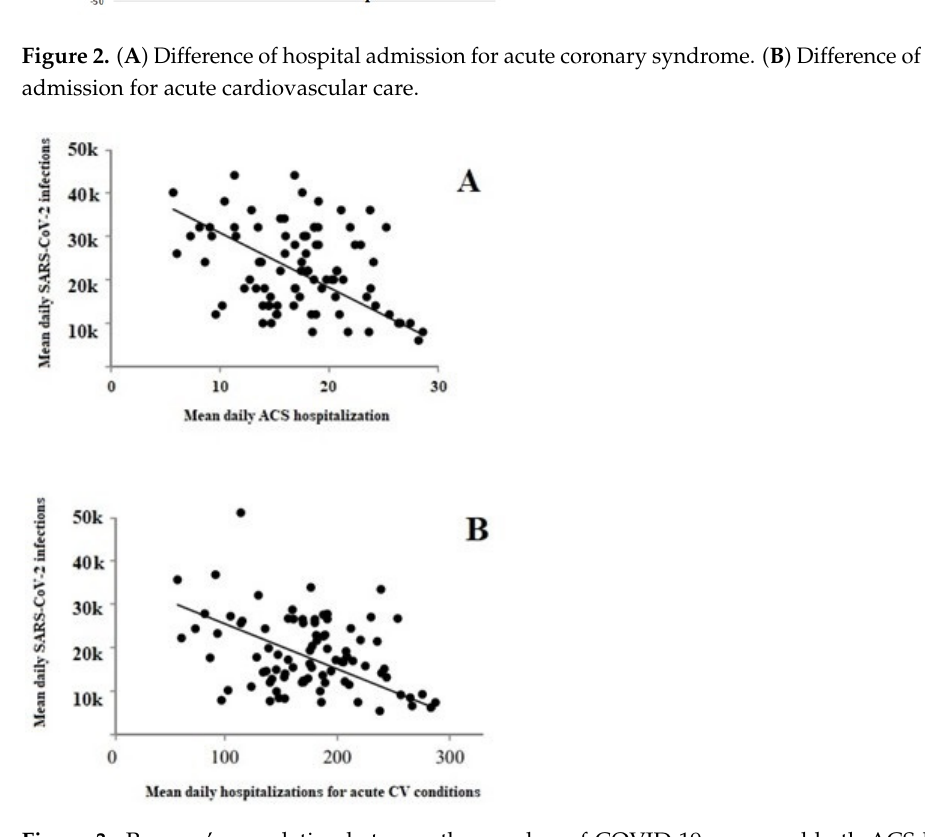
Figure 3. Pearson’s correlation between the number of COVID-19 cases and both ACS hospital admissions (Panel ( A )) and hospitalizations for acute CV conditions (Panel ( B )).